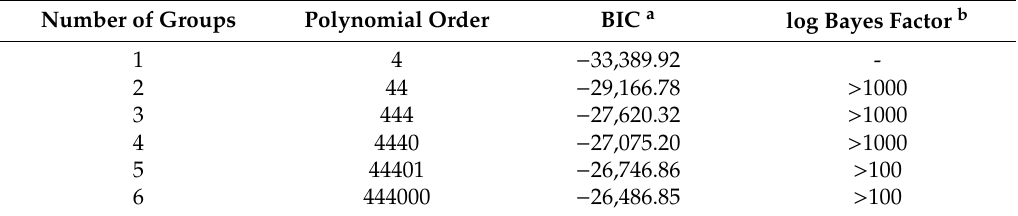
Table 2. Summary of model selection